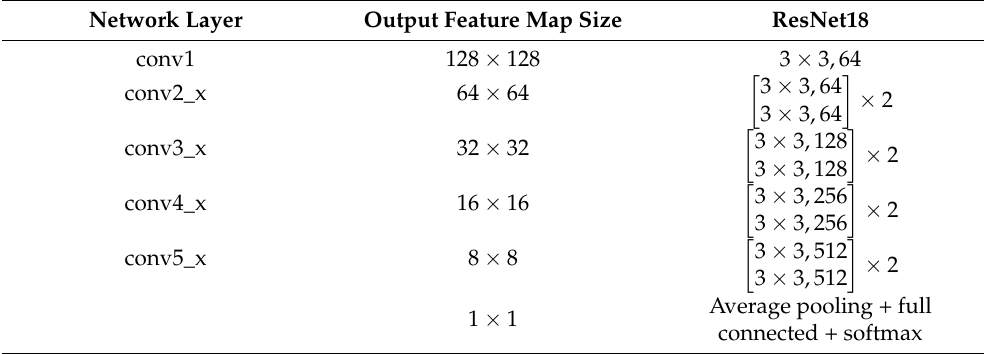
Table 1. Modified ResNet18 network structure.